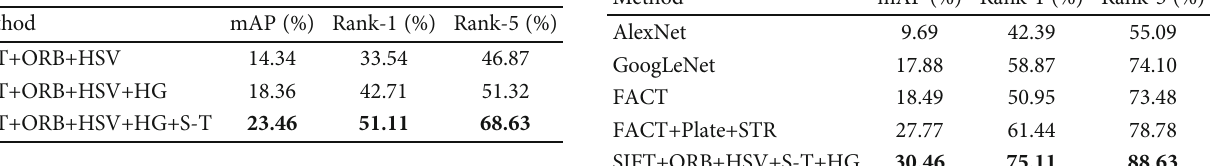
Figure 4: Dataset of fi ve points of Tong Zhou G103 entering Beijing. Table 1: ReID accuracy of Airport Expressway vehicles entering Table 4: Accuracy comparison of ReID Beijing.